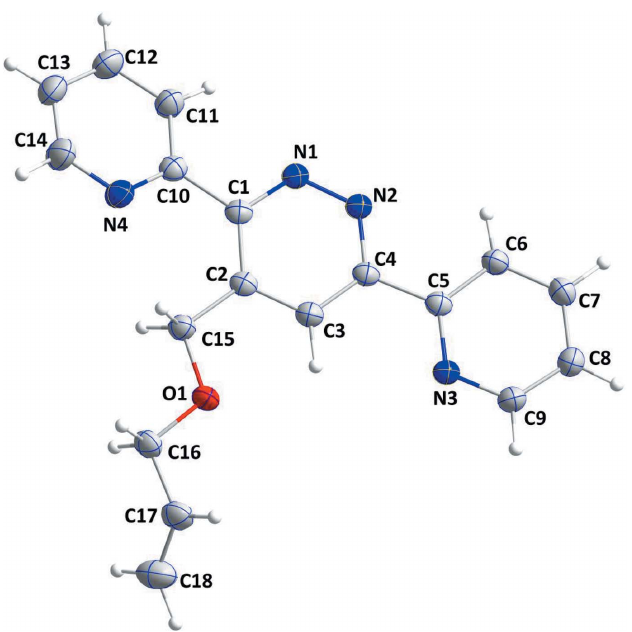
Figure 1 The molecular structure of the title compound with the atom-numbering scheme. Displacement ellipsoids are drawn at the 50% probability level.